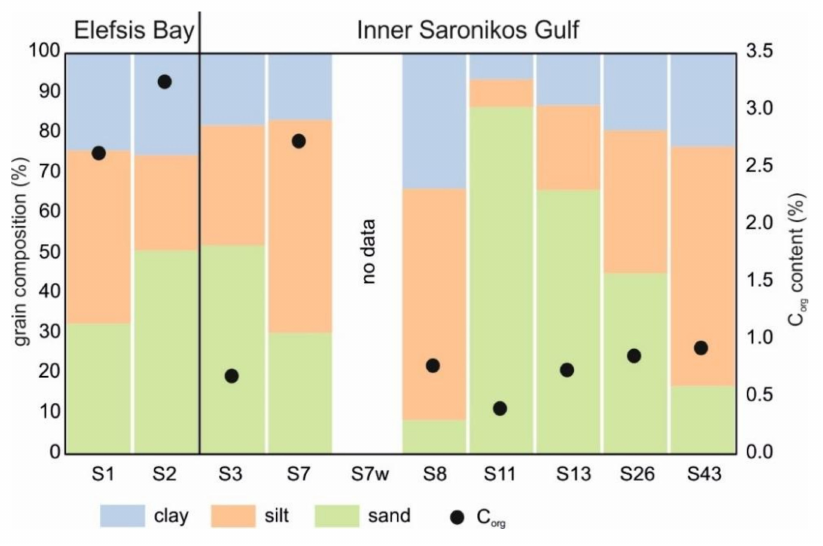
Figure 2. Sediment fractions and C org